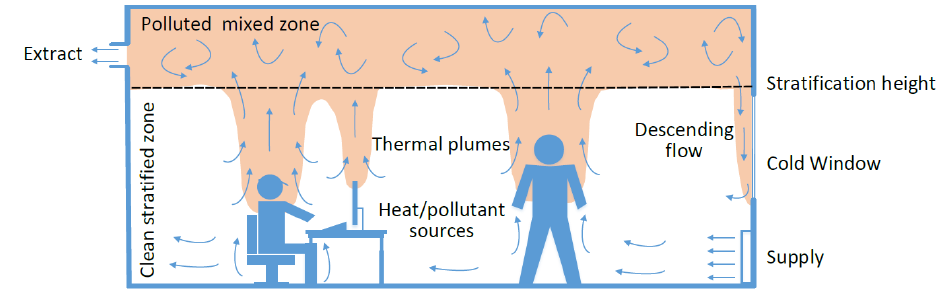
Figure 1. Illustration of displacement